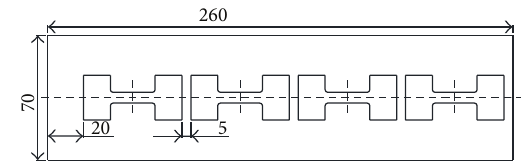
Figure 5: Nesting the specimens on the blank (mm).